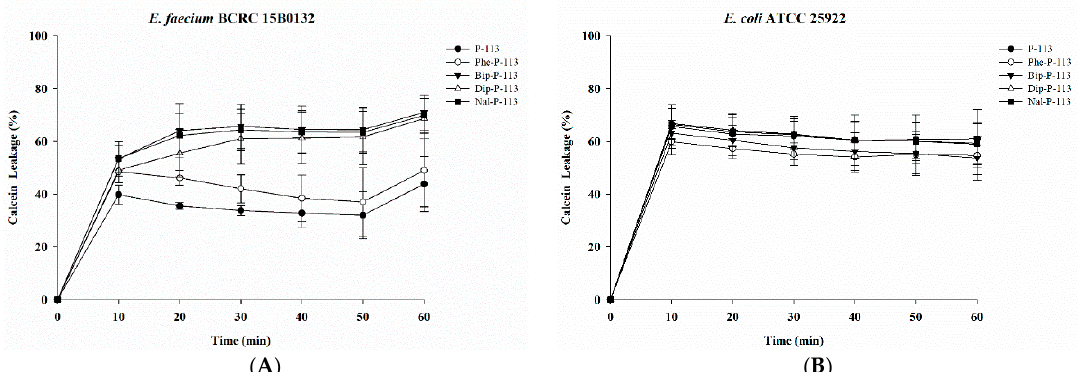
Figure 1. Membrane permeabilization of vancomycin-resistant Enterococcus faecium (VRE) and Escherichia coli strains. The membrane permeabilization of ( A ) E. faecium BCRC 15B0132, and ( B ) E. coli ATCC 25922 by P-113, Phe-P-113, Bip-P-113, Dip-P-113 and Nal-P-113 for 60 min exposure. Calcein-AM loaded cells (10 7 CFU/mL) were resuspended by PBS, and the aliquots of 100 µL were added into a sterile black-wall 96-well plate, then treated with 0.5 × MIC of peptides in each well and measured the calcein leakage immediately. The experiments were performed in triplicate.